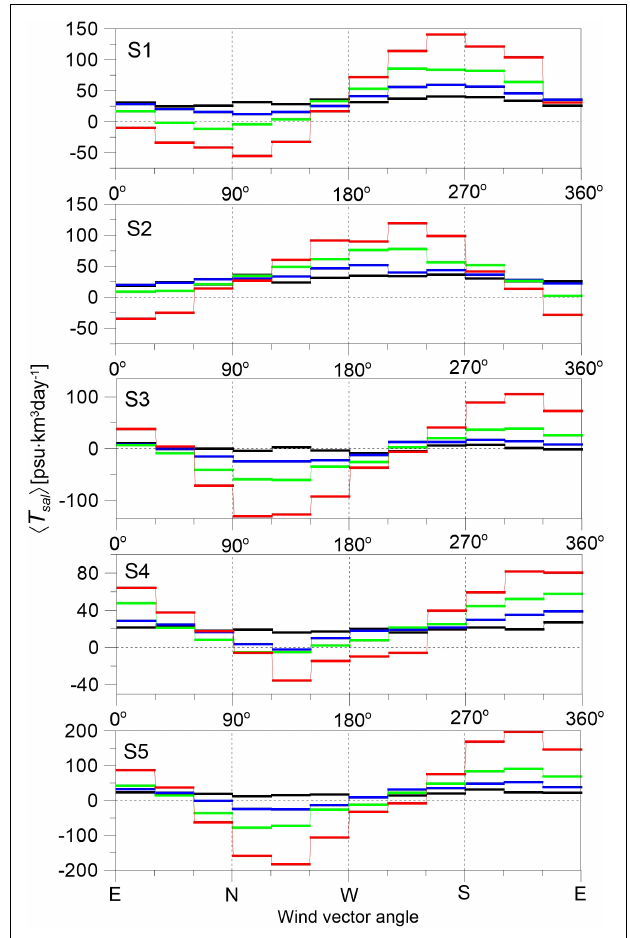
FIGURE 5 | The partial mean value (cid:104) T sal (cid:105) of the daily saltwater transport T sal through the five cross-sections S1–S5 for 12 ranges of the wind velocity vector angle and 4 ranges of the daily mean friction velocity u ∗ estimated from the 10-year time series. The friction velocity ranges